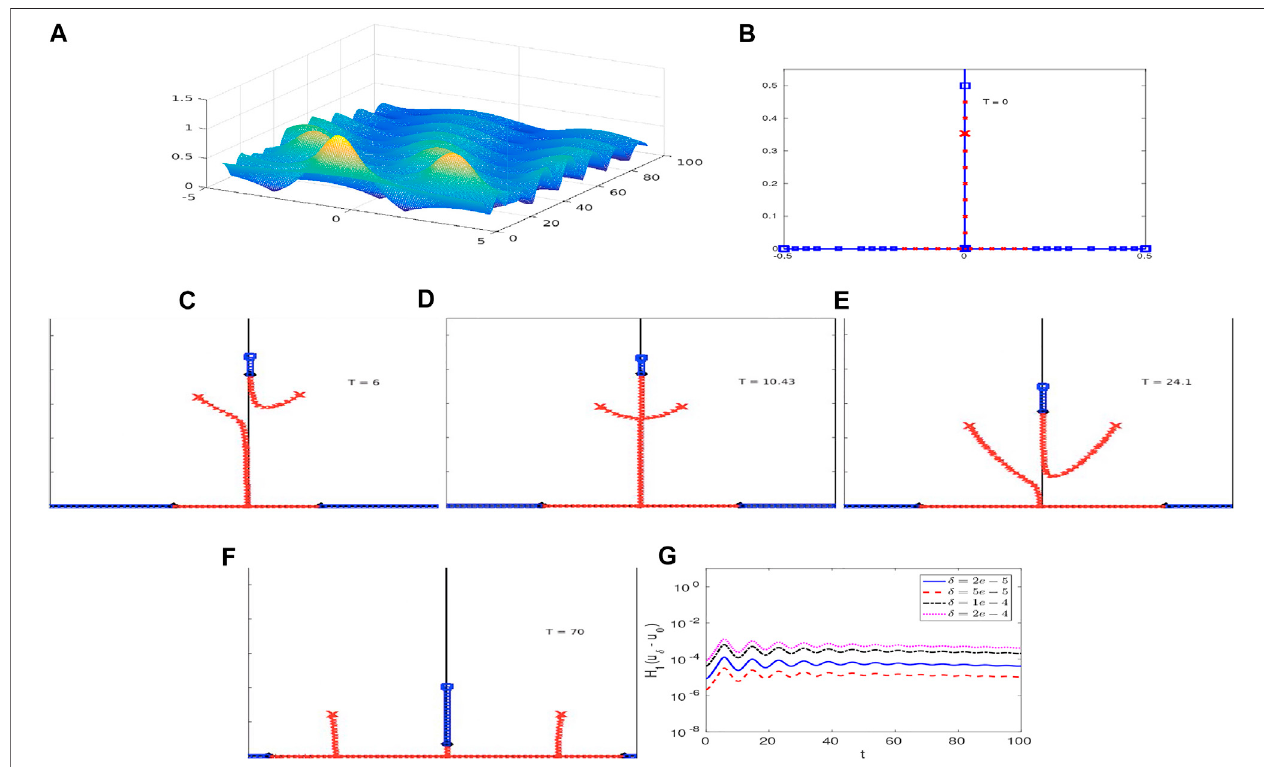
(cid:12)(cid:12)(cid:12)(cid:12)(cid:12) (cid:12)(cid:12)(cid:12)(cid:12)(cid:12) FIGURE 5 | One UM regime: (A) U ( 1 ) ε , c ( x , t ) for 0 ≤ t ≤ 100 and the spectrum at (B) t (cid:1) 0, (C) t (cid:1) 6, (D) t (cid:1) 10 . 43, (E) t (cid:1) 24 . 1, (F) t (cid:1) 70 and (G) η ( t ) for f 4 ( x , t ) , δ (cid:1) 10 − 5 , ... , 10 − 4 and ε (cid:1) 0 . 05, c (cid:1) 0 . 01. (cid:1) 0 . 5 i , indicated by a large “ box ” , of spectrum with end point at λ s 0 (cid:1) 0 . 3535 i , indicated by a large and one imaginary double point at λ d 1 “ × ” ( Figure 5B ). Under the damped HONLS λ d splits asymmetrically 1 forming a right state, with the upper band of spectrum in the right quadrant and the lower band in the left quadrant, consistent with the short time perturbation analysis in Section 4 . The right state is clearly visible at t (cid:1) 6 in Figure 5C with the waveform characterized by a single damped modulated mode traveling to the right. The spectrum persists in a right state with the separation distance between the two bands varying until t (cid:1) 10 . 43, Figure 5D , when a cross state forms withan embedded critical point indicating an instability. Subsequently the critical point splits into a right state. As damping continues the band in the right quadrant widens, Figure 5E , and the vertex of the loop eventually touches the origin at t ≈ 27 . 5 . The spectrum then has , λ s , λ + three bands emanating off the real axis, with endpoints λ − 1 0 1 which, as damping continues, diminish in amplitude and move away from the imaginary axis, Figure 5F .